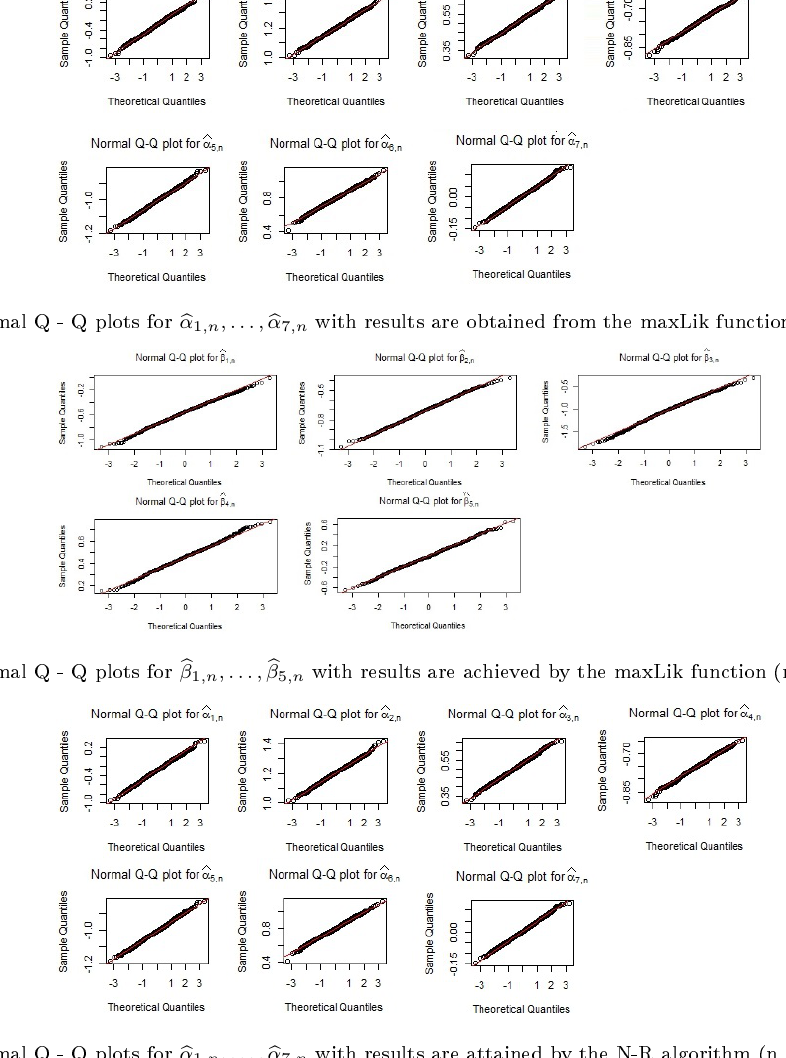
Fig. 3: Normal Q - Q plots for (cid:98) α 1 ,n ,..., (cid:98) α 7 ,n with results are attained by the N-R algorithm (n = 500)